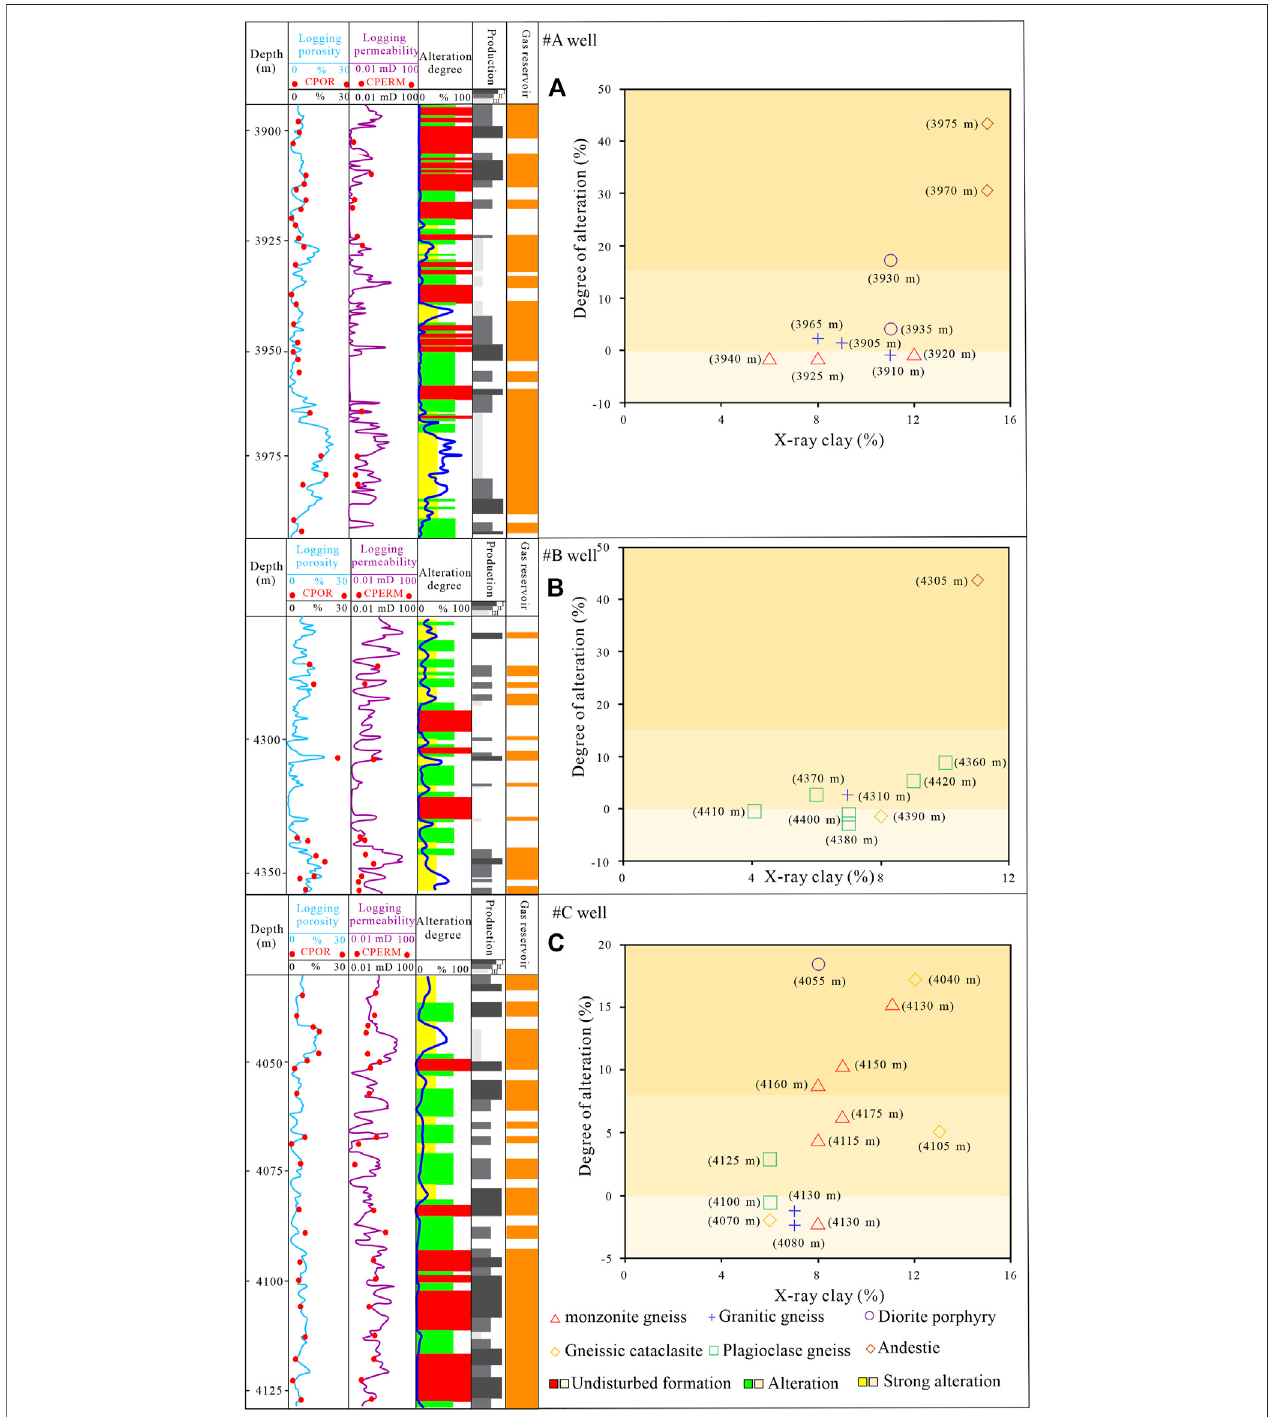
FIGURE7| Relationshipbetweenclayminerals, physical properties,and thedegree ofrock alteration. (A) Archean buried hillofwellBozhong19-6-A; (B) Archean buried hill of well Bozhong 19-6-B; (C) Archean buried hill of well Bozhong 19-6-C.